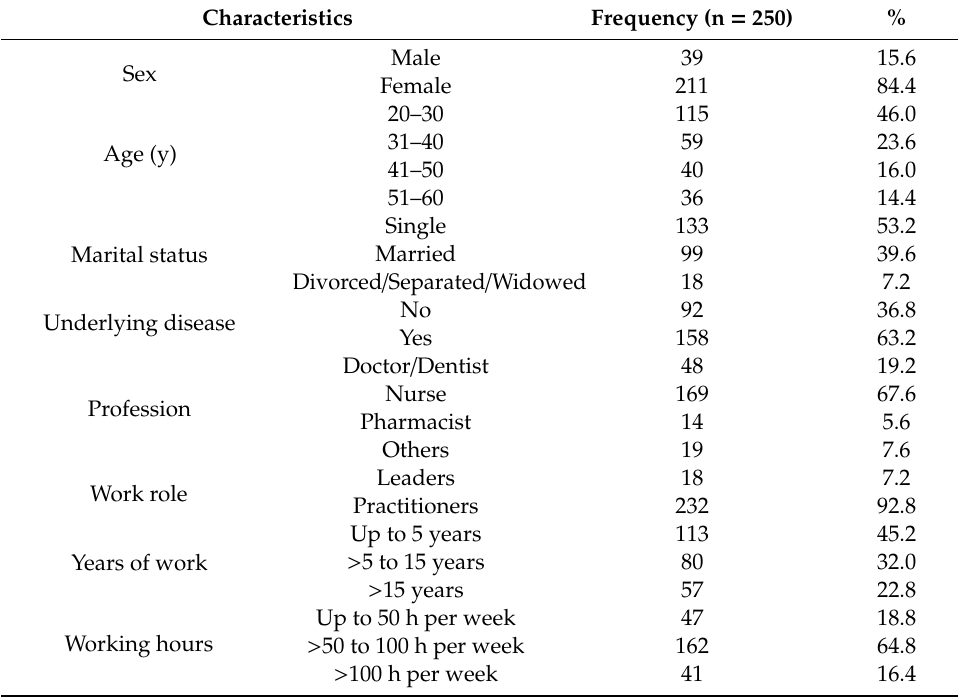
Table 2. Characteristics of the participants.